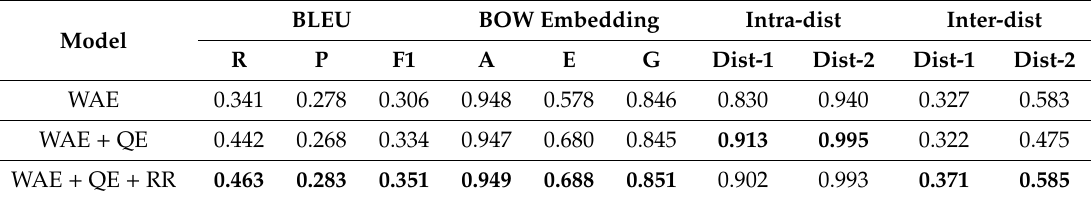
Table 2. Performance comparison based on change in architecture.